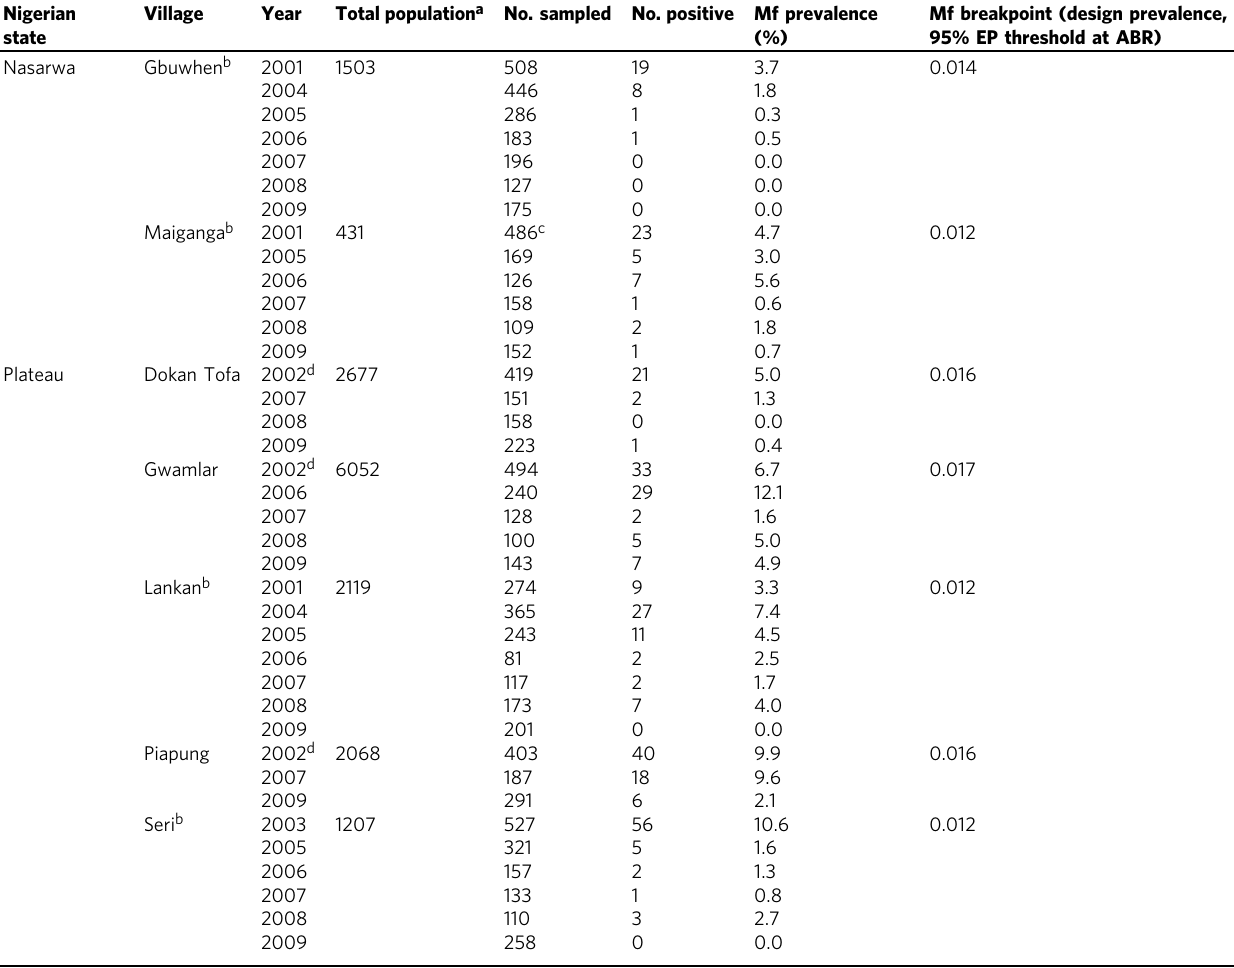
Table 2 LF survey data for Nigerian villages and corresponding model-predicted Mf prevalence thresholds at ABR Nigerian state Nasarwa